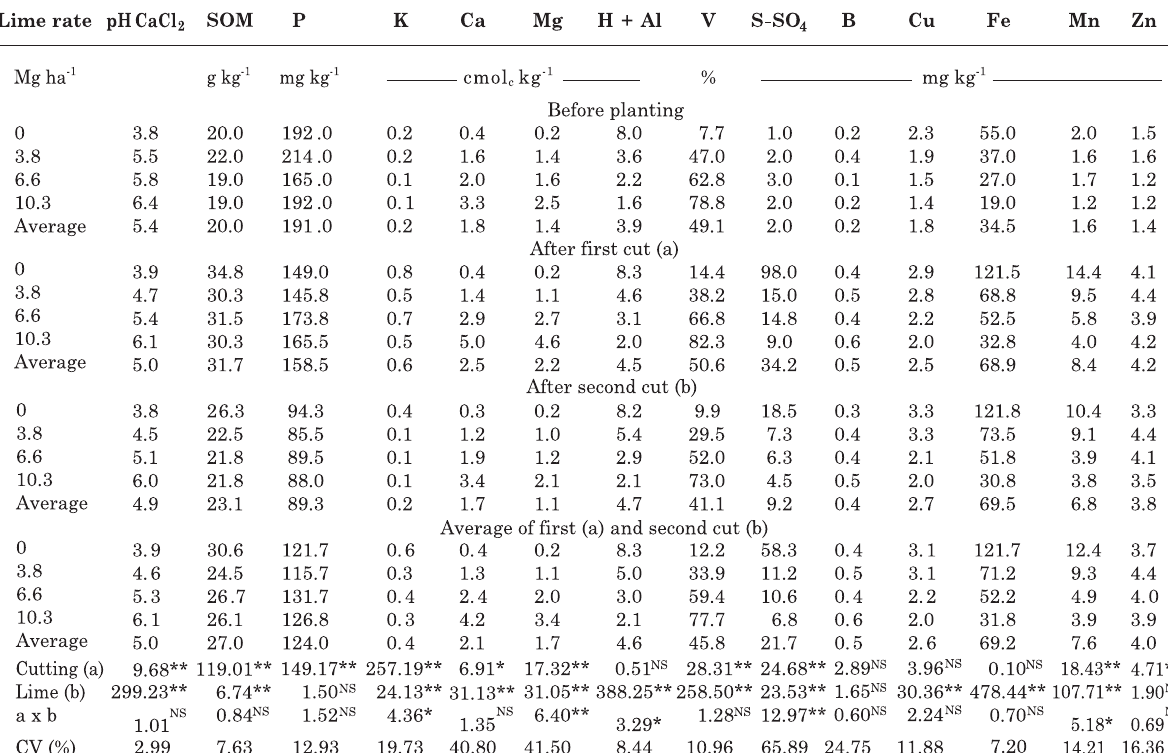
Table 1. Influence of lime rates on soil chemical properties before planting and in first and second